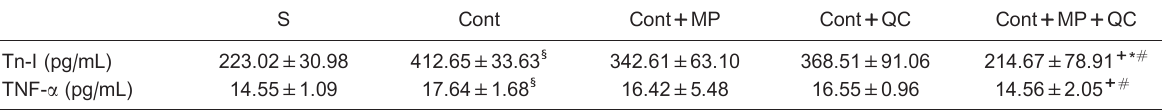
Data are reported as means±SD. S: Sham; Cont: cardiac contusion; MP: methylprednisolone; QC: quercetin; Tn-I: troponin I; TNF- a : tumor necrosis factor-alpha. 1 P , 0.05 compared to S group; + P , 0.05 compared to Cont group; *P , 0.05 compared to Cont++MP